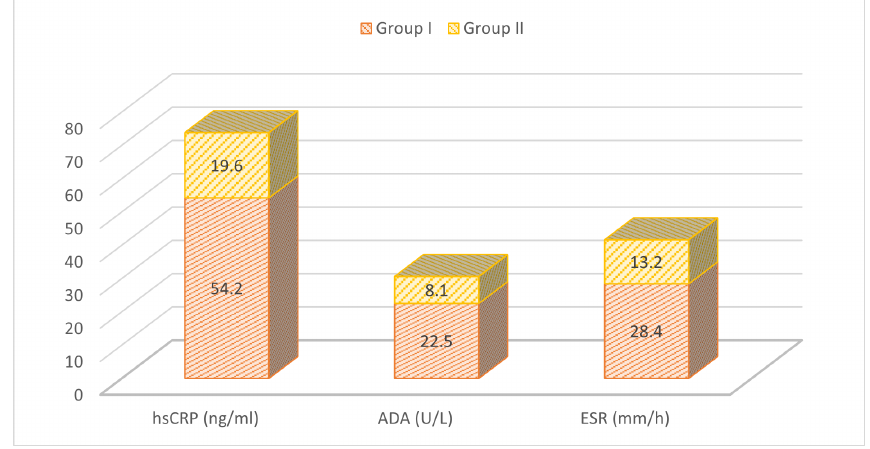
Figure 2. Assessment of